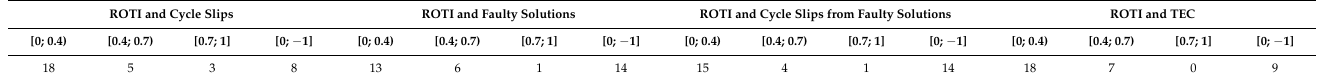
Table 9. Count of Pearson’s correlation coefficients between ROTI and faulty solutions.